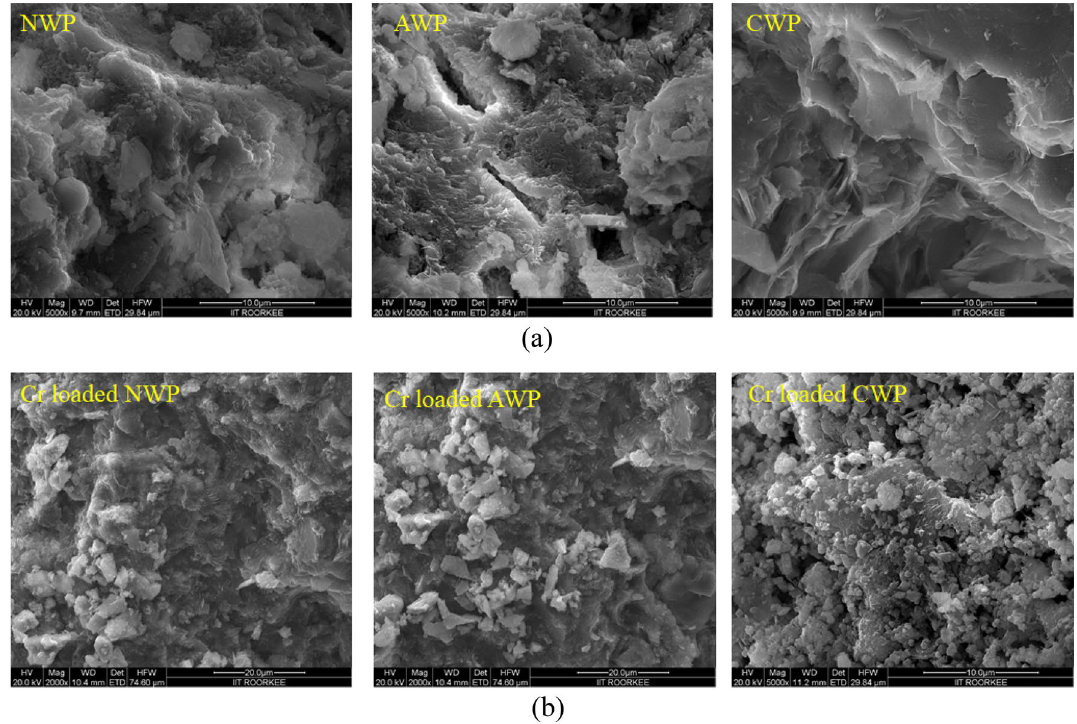
Figure 2. ( a ) Micrographs of native biosorbents ( b ) micrographs of Cr-loaded